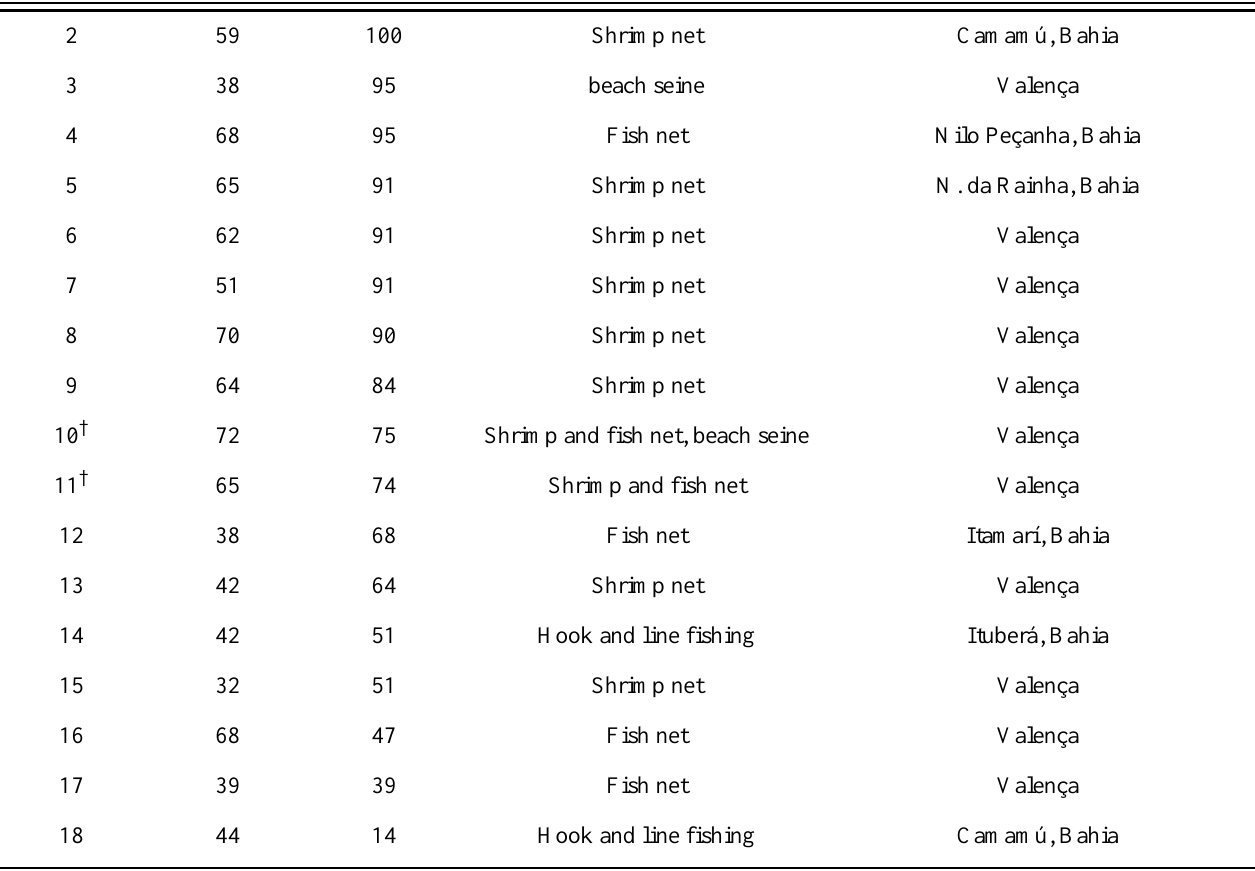
Table 1 . Results of interviews in the neighborhood of Tento in Valença, Bahia State, Brazil. Fishers 4, 5, and 14 were informants who helped to mark the fishing spots by boat. The fishers who were not born in Valença lived there between the ages of 15 and